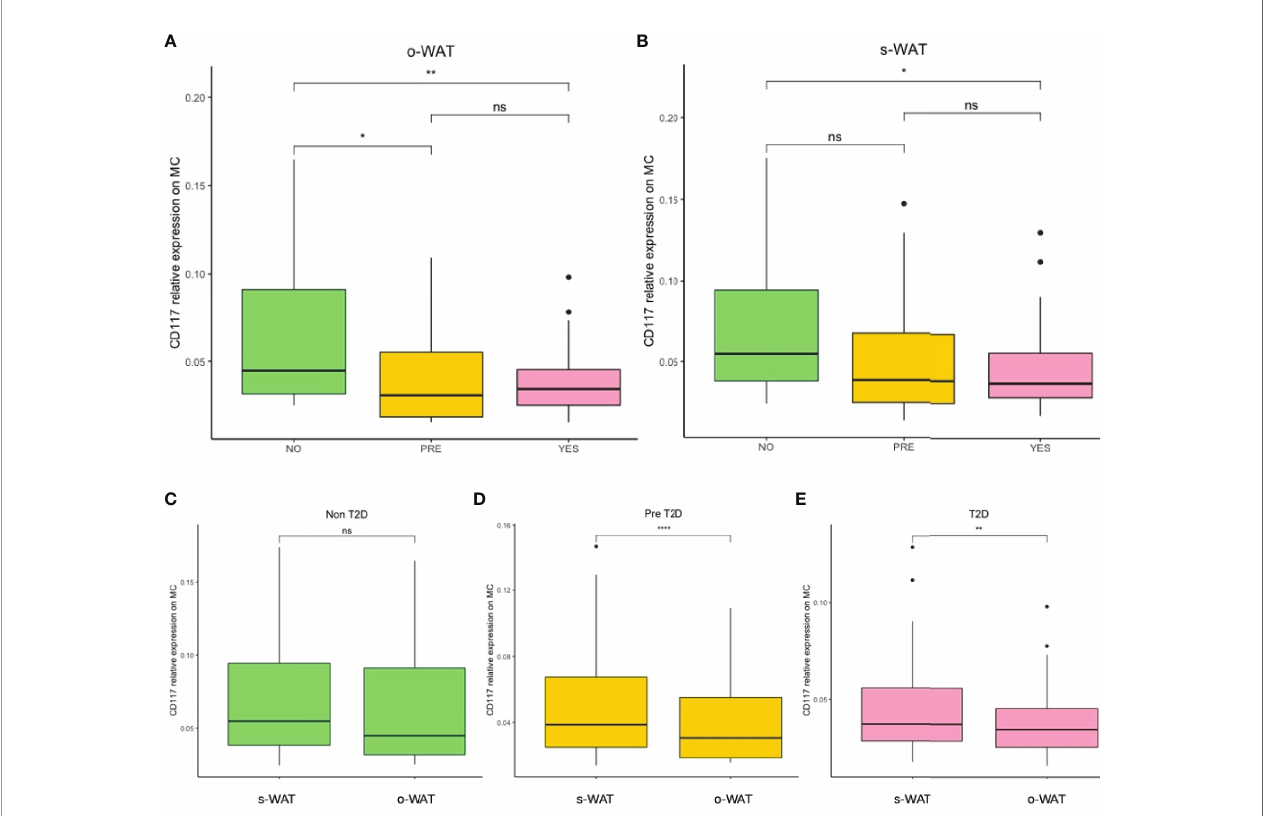
FIGURE 3 | Relative surface expression of CD117 on mast cells. (A) Comparison in o-WAT between the three groups. (B) Comparison in s-WAT between the three groups. (C) Comparison between o-WAT and s-WAT in the non-T2D group. (D) Comparison between o-WAT and s-WAT in the pre-T2D group. (E) Comparison between o-WAT and s-WAT in the T2D group. MC (mast cells), s-WAT (subcutaneous white adipose tissue), o-WAT (omental white adipose tissue), NO (non-type 2 diabetes group), PRE (pre type 2 diabetes group), YES (type 2 diabetes group), T2D (type 2 diabetes), n=96. “ ns ” means not signi fi cant, * (0.05 > p value > 0.01), ** (0.01 > p value > 0.001), **** (0.0001 > p value >